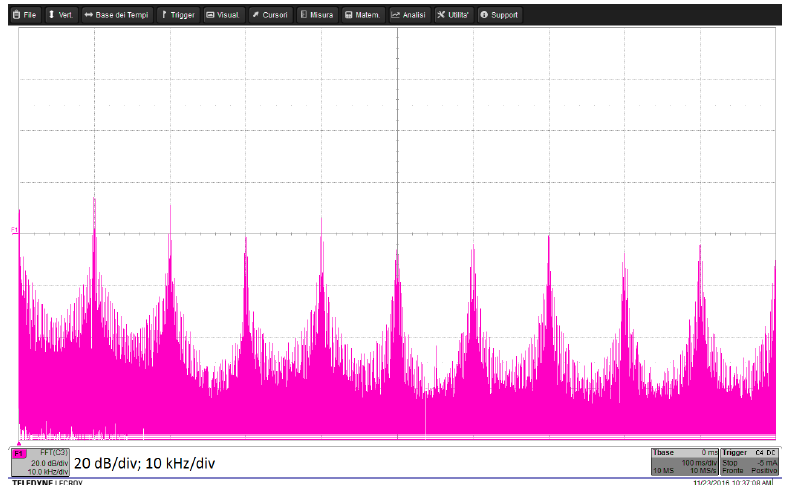
Figure 11. CMV spectrum; H8 architecture and CMMV SVM. Modulation index m = 0.4. Frequency range of 0–100 kHz.